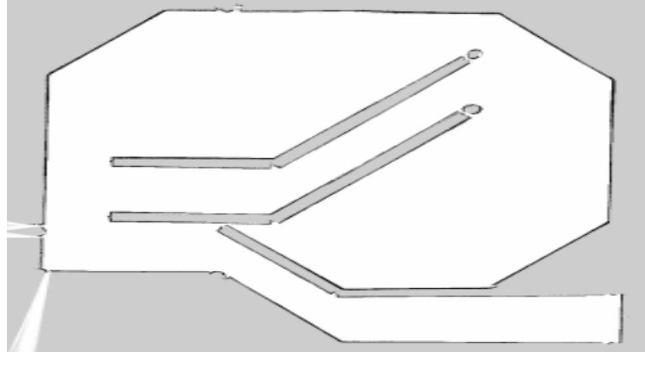
Figure 8. Scene map.